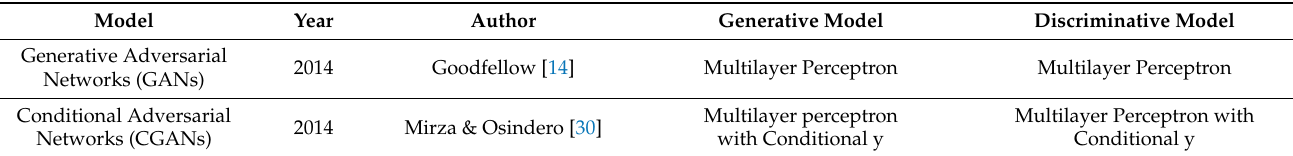
Table 1. A tabular comparison of the generative adversarial networks discussed in this paper.